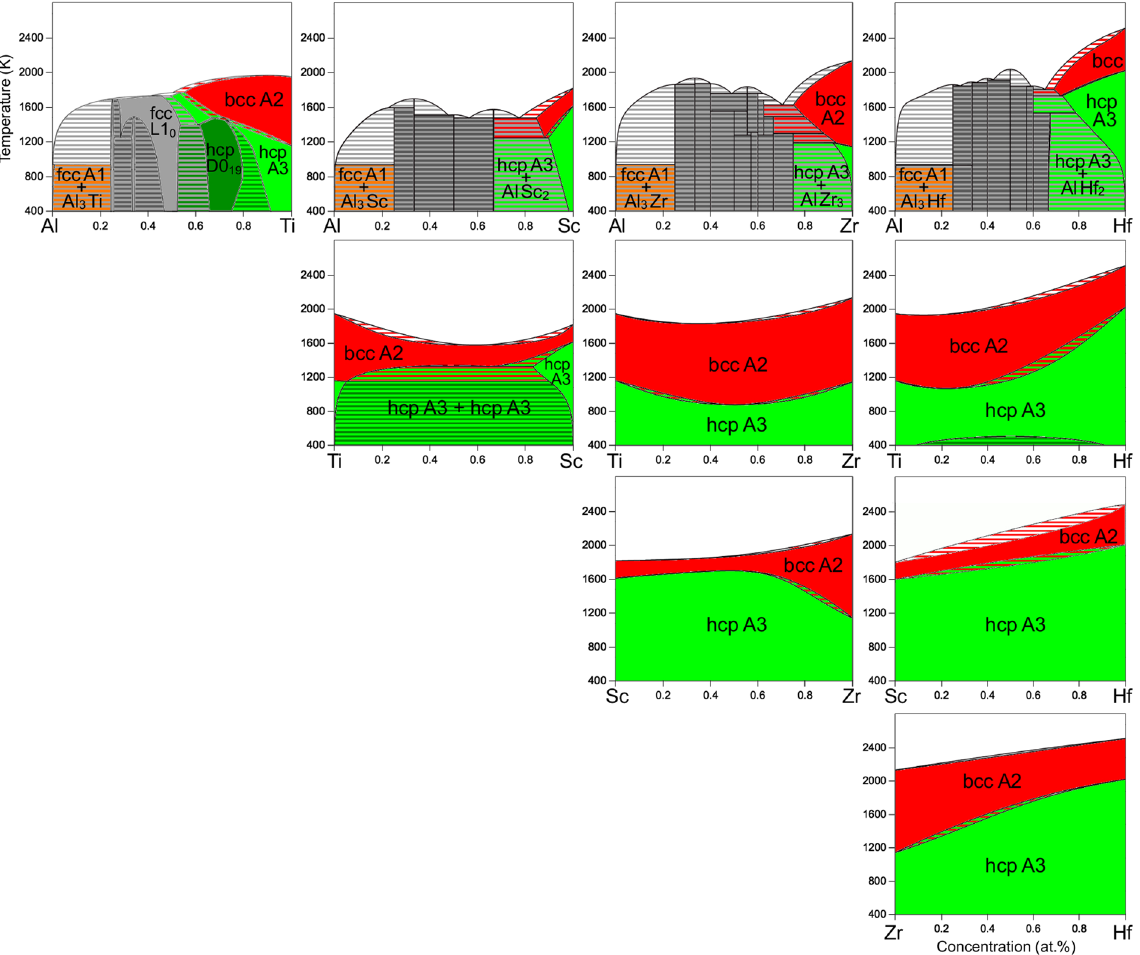
Figure 1. Phase diagrams of all 10 individual constituting binaries of the considered Al-Hf-Sc-Ti-Zr HEA. The phase diagrams for Hf-Ti, Hf-Zr, and Ti-Zr are based on the SGTE (2014) alloy database. The phase diagrams for Al-Hf, Al-Sc, Al-Zr, Sc-Ti, and Sc-Zr are based on the PanSolution database (ipandat.computherm.com). The Al-Ti phase diagram corresponds to the reassessment of Schuster and Palm 69 . The Sc-Hf phase diagram has been taken from ref. 70. and extended to temperatures below 1200 K by a hcp A3 single phase field.